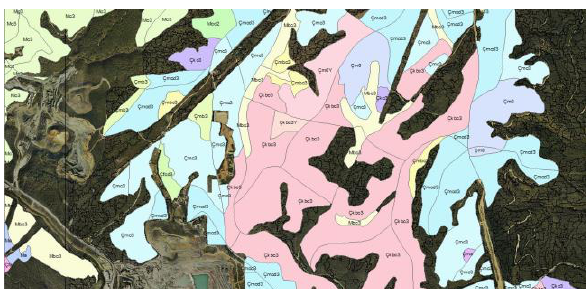
Fig. 6. Field plots on the forest